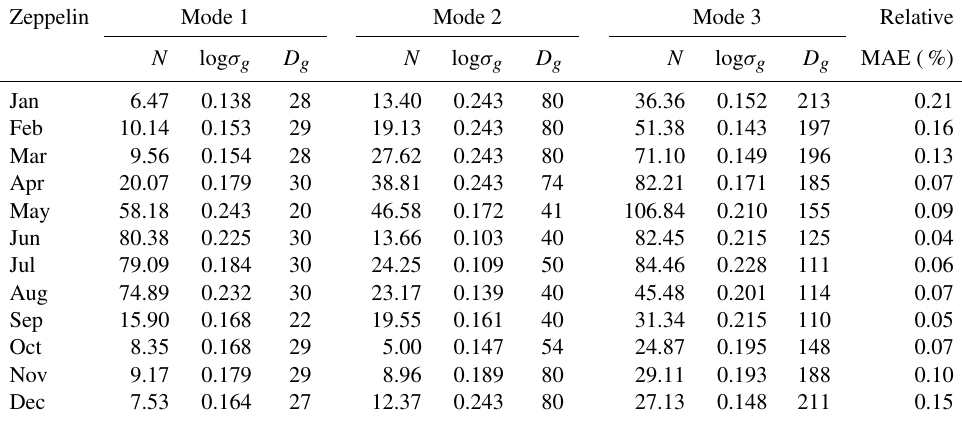
Table A5. Same as Table A1 but for